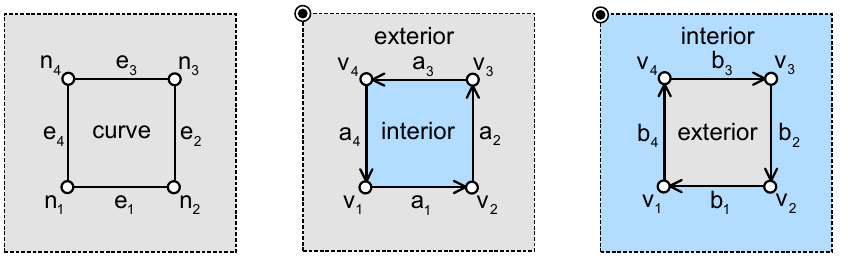
Figure 6. Faces with polygonal boundary curves.